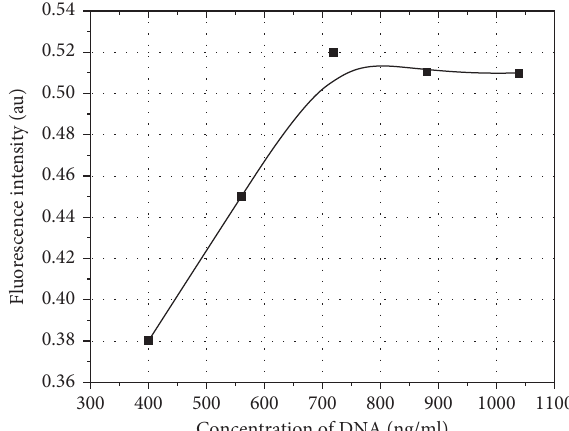
Figure 17: Emission spectra of coumarin 3 (1 × 10 − 5 M) in the presence of different concentrations of DNA in a 0.1M Tris-HCl buffer.